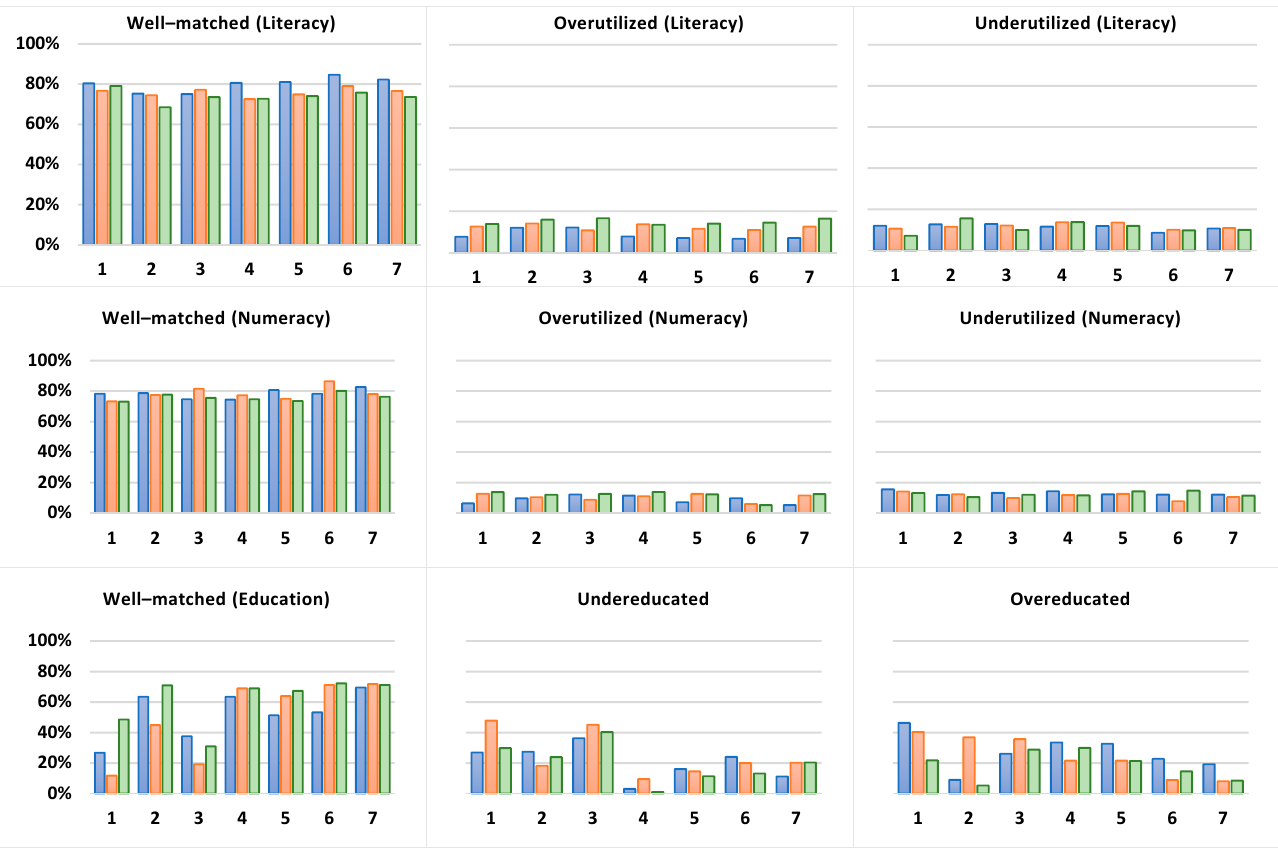
Figure 6. Skill and educational mismatch by occupational level. Note: blue—IALS (1994); orange—ALL (2003); green— PIAAC (2012); 1—ISCO 1; 2—ISCO 2; 3—ISCO 3; 4—ISCO4; 5—ISCO5; 6—ISCO 7; 7—ISCO 8.